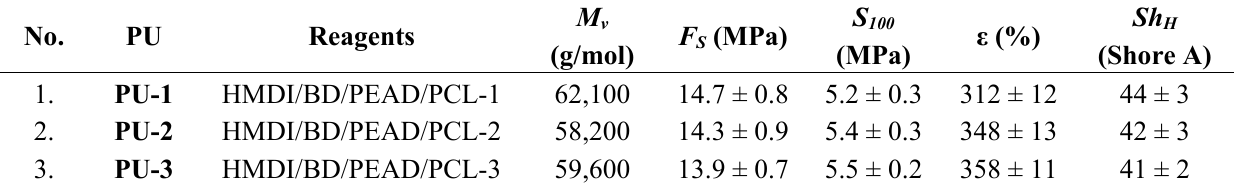
Table 1. Characterization of synthesized polyurethanes.